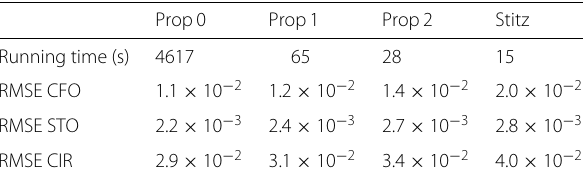
Table 2 Comparative running time and RMSE estimation